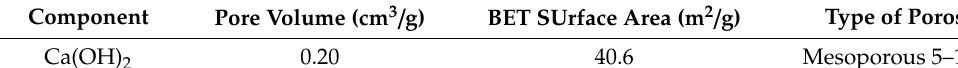
Figure 3. ( a ) Adsorption and desorption curve; ( b ) Pore size distribution of Ca(OH) 2 . Table 4. BET results of Ca(OH) 2 nanoparticles.